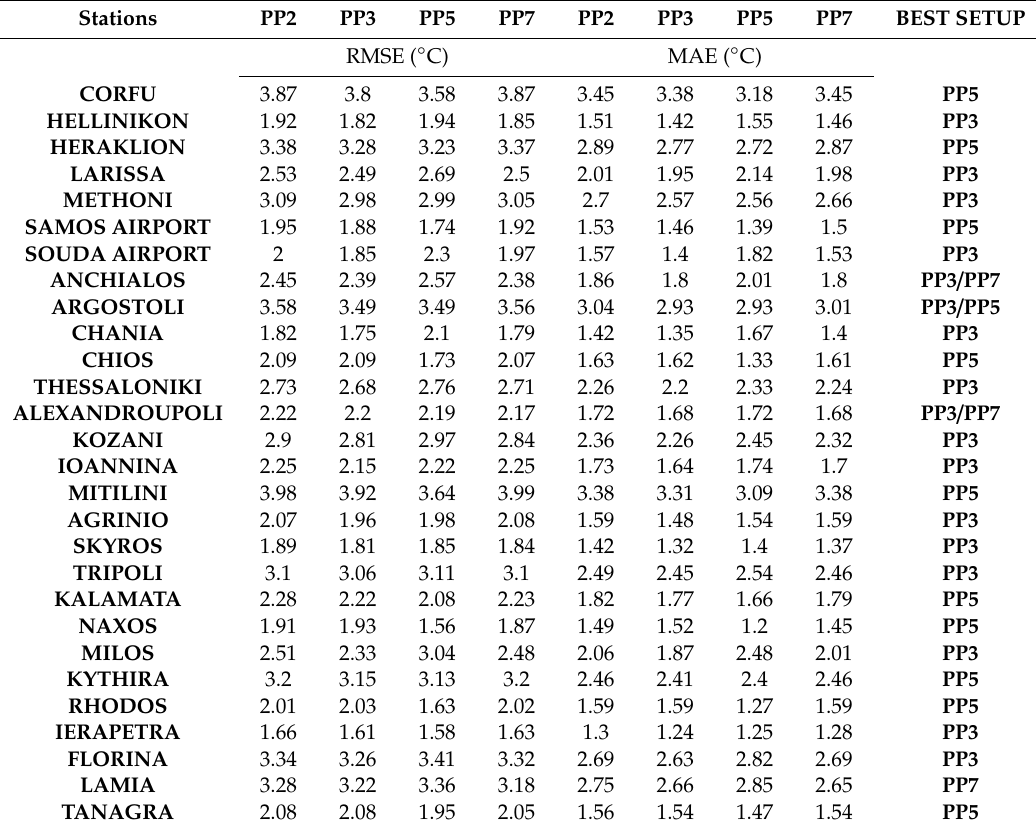
Table 7. Values of statistical metrics of root mean squared error (RMSE) and mean absolute error (MAE), regarding TX for the four di ff erent setups classified by station. The final column indicates the best setup by